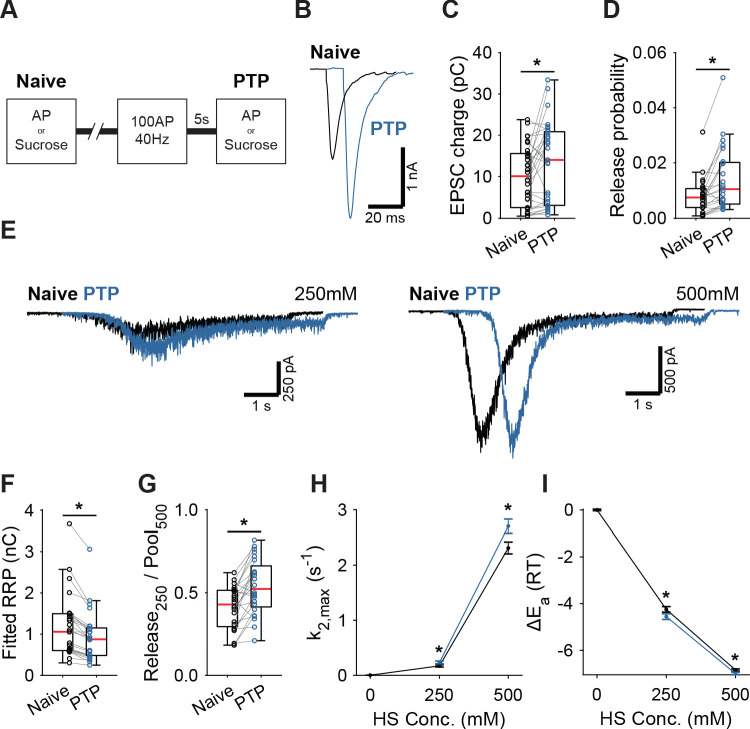
Post-tetanic potentiation causes a decrease in the fusion energy barrier.(A) Overview of protocol used to induce PTP. (B) Representative traces of AP-evoked release before (Naive) and after PTP in WT synapses, overlaid with 10 ms offset, and (C) boxplots of charge transferred during the first evoked EPSC and (D) release probability calculated by dividing the EPSC charge by the HS-derived RRP charge (F). (E) Representative traces of HS-induced release before and after PTP, overlaid with 1 s offset, at 250 mM and 500 mM HS, and boxplots of (F) RRP charge estimated from 500 mM HS, and (G) depleted RRP fraction at 250 mM HS before (Naive) and after PTP. (H) Plots (mean ± S.E.M.) of maximal HS release rates, and (I) change in the fusion energy barrier at different HS concentrations before (Naive) and after PTP. (*p<0.05, Wilcoxon signed-rank test).
Figure 4—source data 1.Statistics overview.